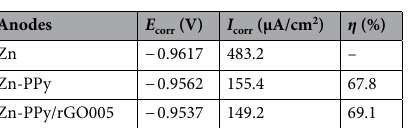
Figure 5. ( a ) Cyclic voltammograms of sample anodes at scan rate of 1.0 mV/s, ( b ) Voltage–time profile of plating/striping process using symmetric cell at current density of 0.5 mA/cm 2 (inset: enlarged potential profiles at different times), FESEM images of ( c ) Zn, ( d ) Zn-PPy, and ( e ) Zn-PPy/rGO005 anodes after 50 cycles (25 h) of plating/striping process, ( f ) Linear polarization curves of anode samples, and ( g ) Schematic illustrations of the zinc deposition process on anodes.